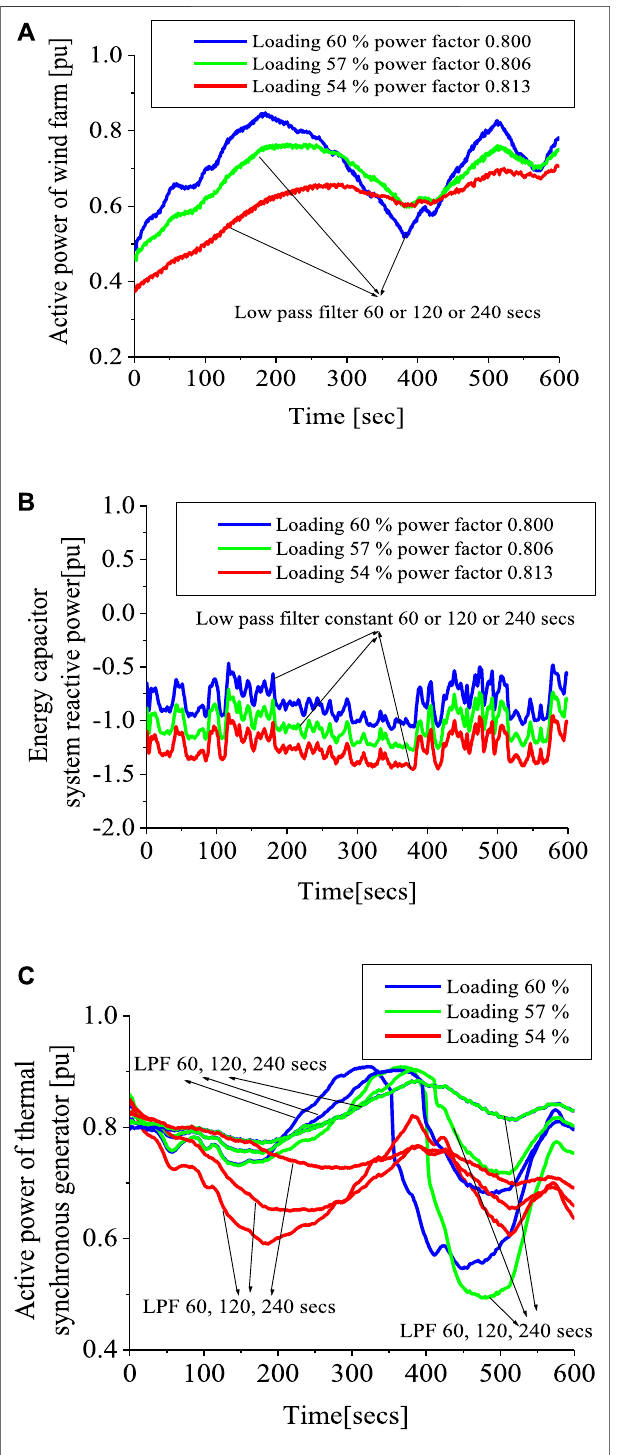
wind farm for all scenarios. (B) Reactive power of ECS for all scenarios. (C) Active power of the thermal steam turbine for all